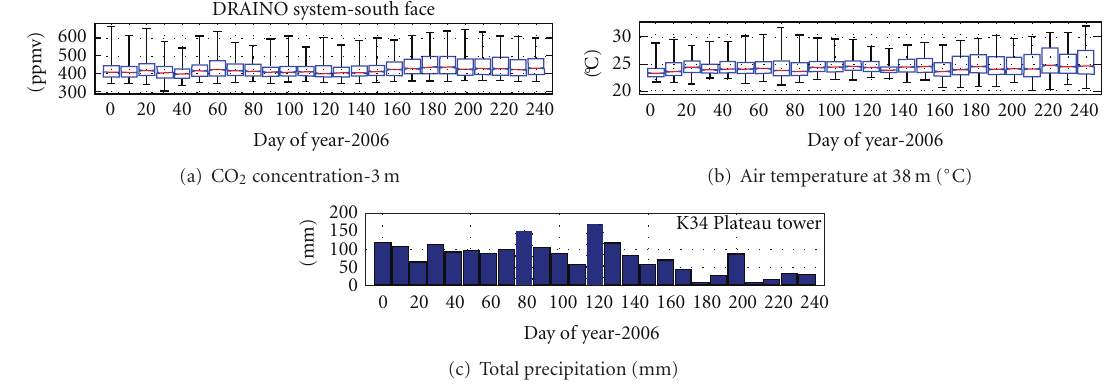
Figure 5: 10 days time series of the CO 2 concentration (a), air temperature (b) (DRAINO system), and total precipitation (c) (plateau